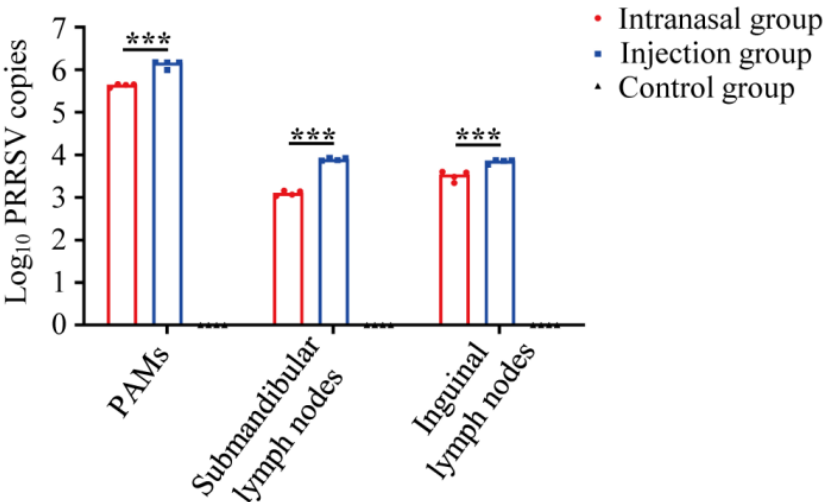
Figure 2. Viral loads of tissues after inoculation. Viral loads were quantified in tissues through RT-qPCR in piglets. Tissues were obtained after necropsy at 43 dpi. Piglets in the control group were PRRSV-negative. Statistical differences were determined using the t -test (*** p < 0.001). Comparisons were between the Intranasal and the Injection groups.